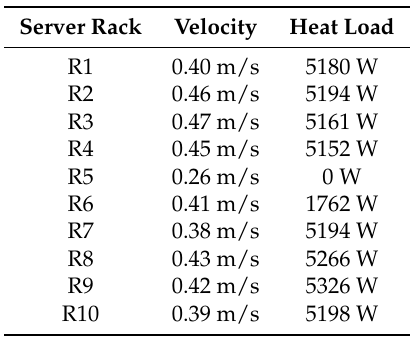
Table 2. Boundary conditions for the server